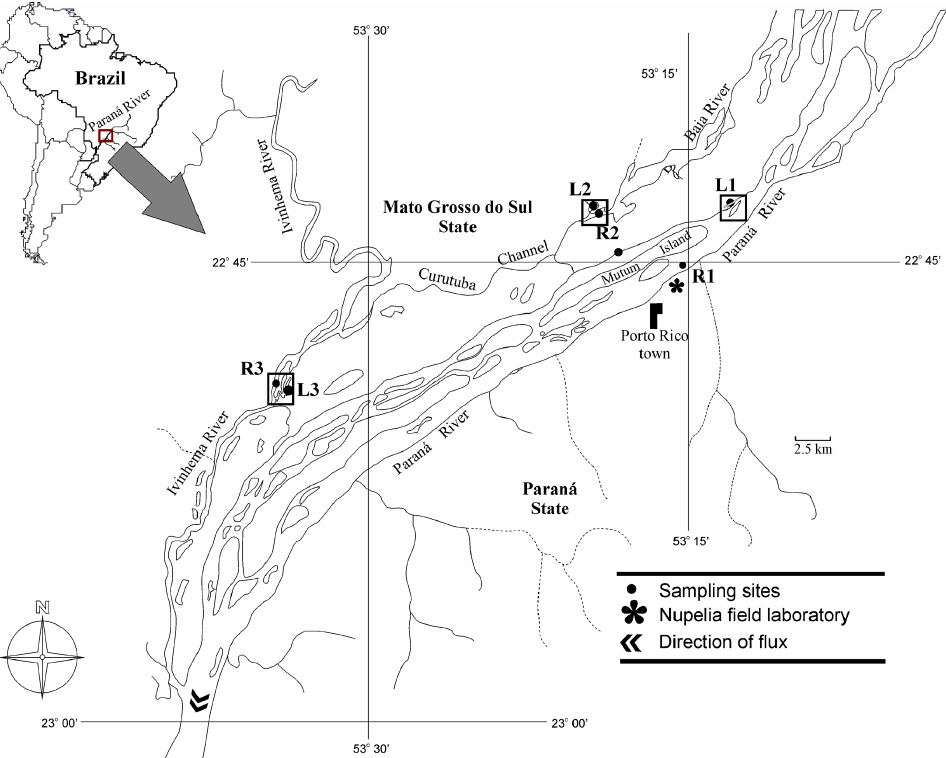
Figure 1. Map and localization of sampling sites in the upper Paraná River floodplain (R1: Paraná River; R2: Baia River; R3: Ivinhema River; L1: Garças lake; L2: Guaraná lake; L3: Patos